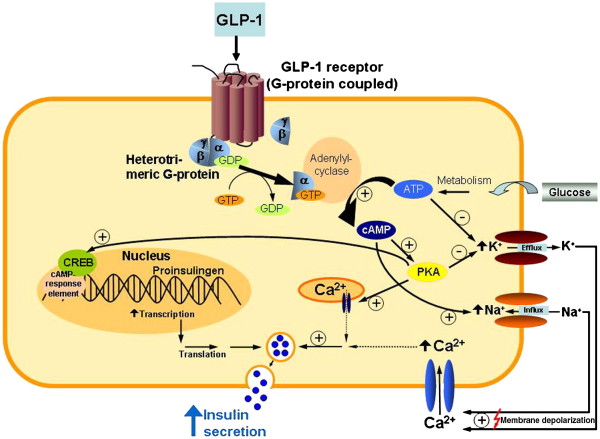
Mechanism of action of GLP-1 [25].